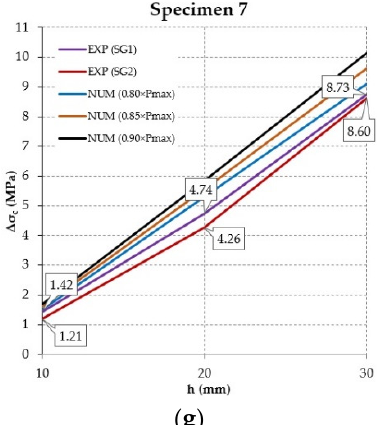
Figure 20. Comparison of experimental and numerical analyses. 1 ( a ); 2 ( b ); 3 ( c ); 4 ( d ); 5 ( e ); 6 ( f ); 7 ( g ).